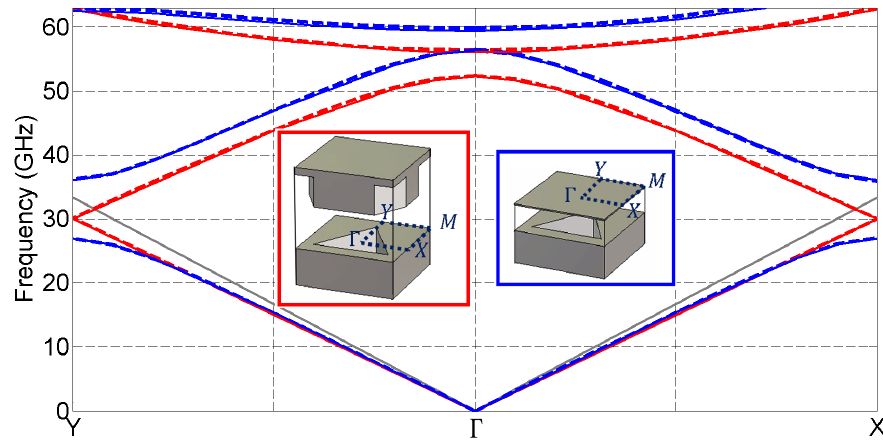
Figure 3. Dispersion diagram of the glide-symmetric (red lines) and mirror-symmetric (blue lines) unit cells. Dashed lines represent the results extracted from CST and solid lines the results extracted from the mode-matching. The light line is displayed in